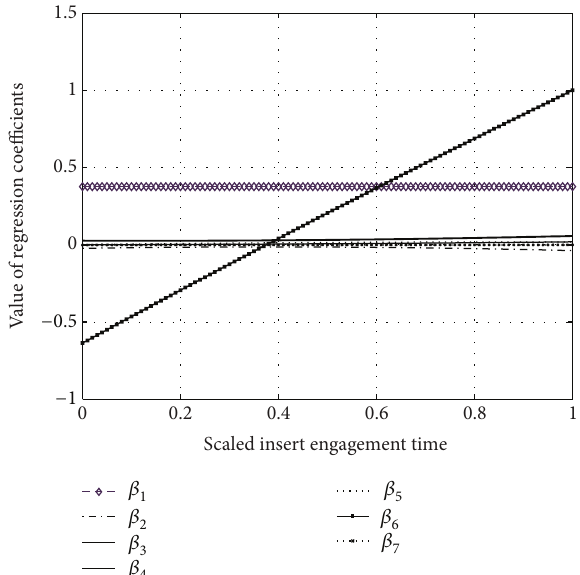
Figure 6: Regression coefficient functions 𝛽 1 to 𝛽 7 .